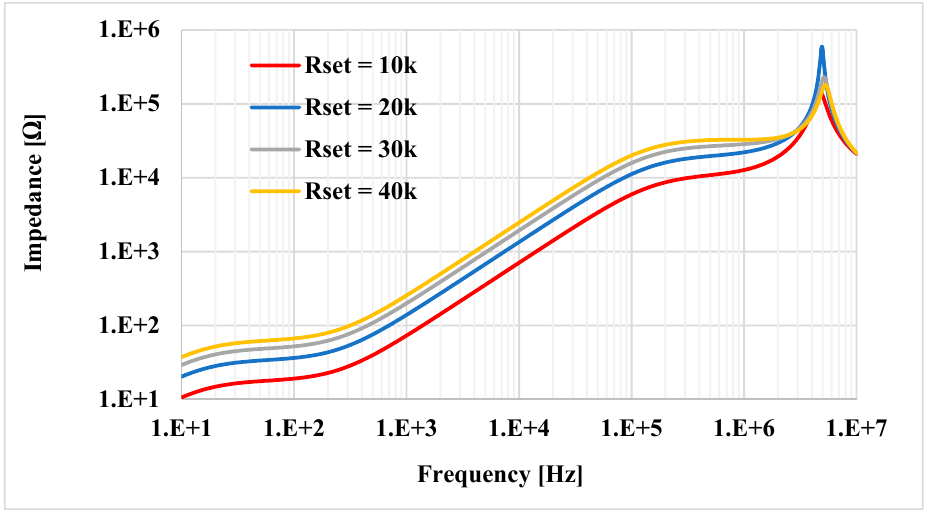
Figure 24. The frequency responses of the parallel L-R connection with different R set .